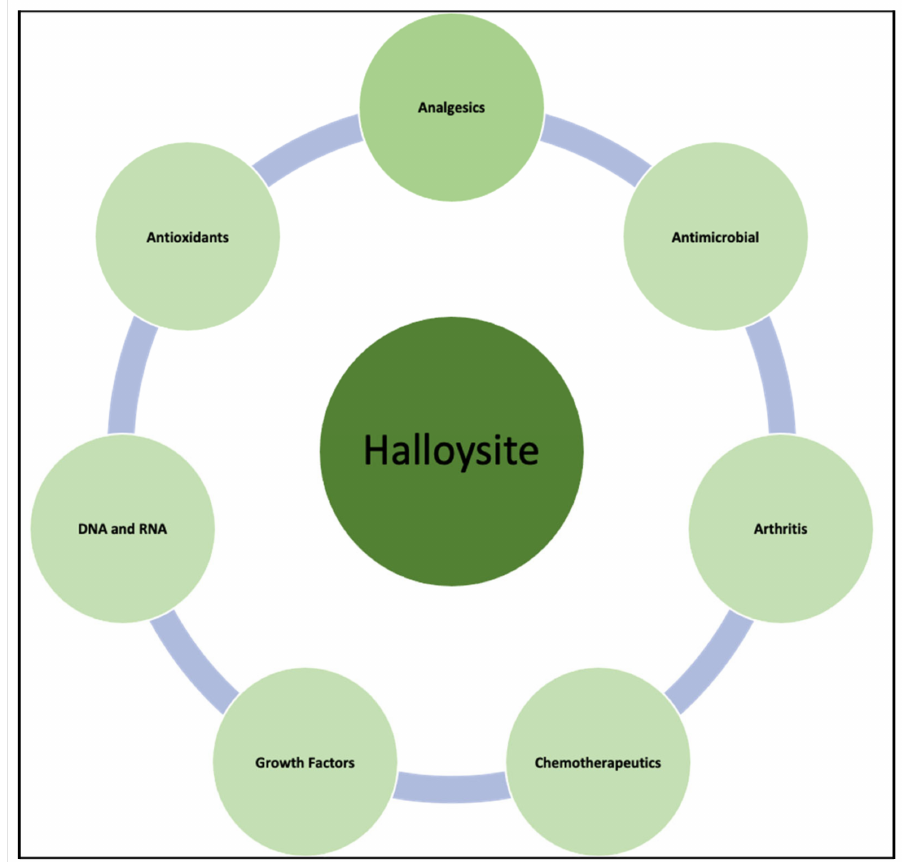
Figure 7. Types of drugs loaded onto halloysite